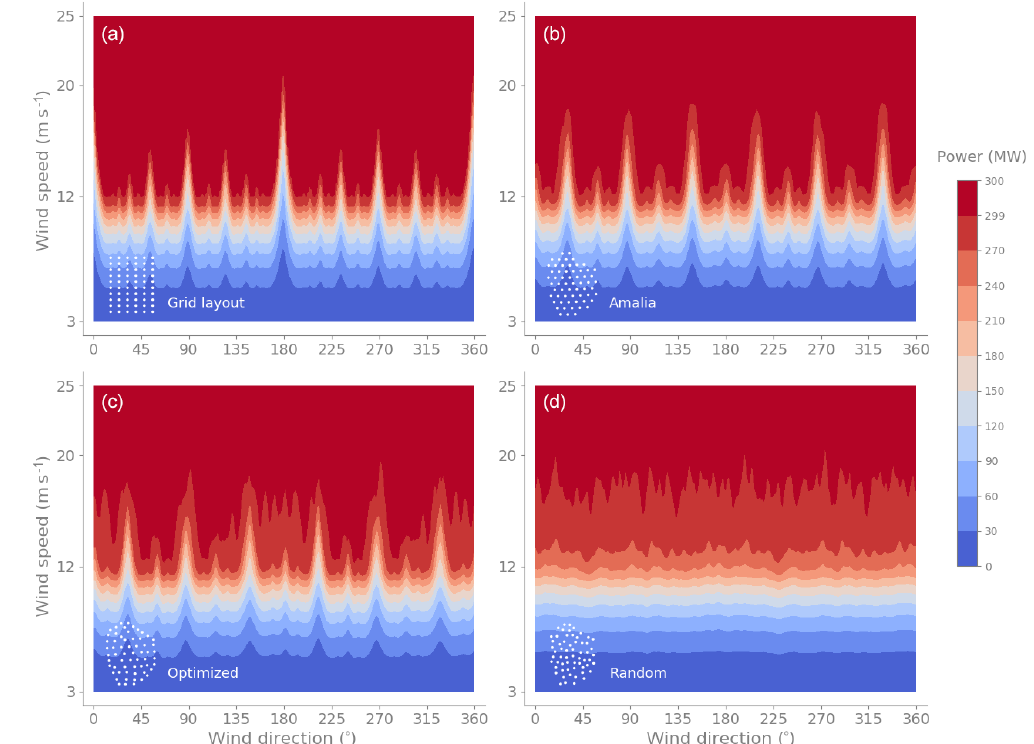
Figure 5. Power contours as a function of wind direction and wind speed for the Grid, Amalia, Optimized, and Random layouts. The grid-like layouts (a, b) have larger peaks due to wind turbines being aligned along particular directions and thus experiencing full-wake conditions. For all layouts, as the speed increases the power increases until the wind farm reaches its rated power of 300MW.